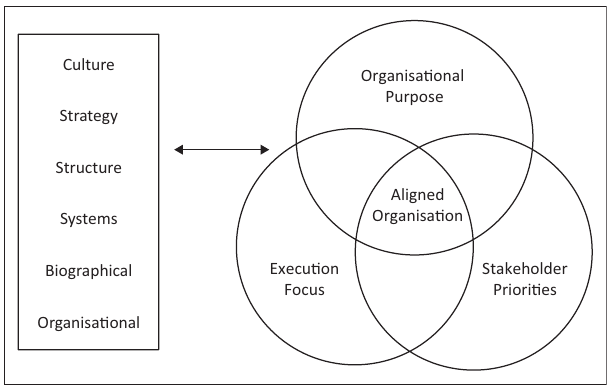
FIG URE 1: Context of organisational alignment enablers.